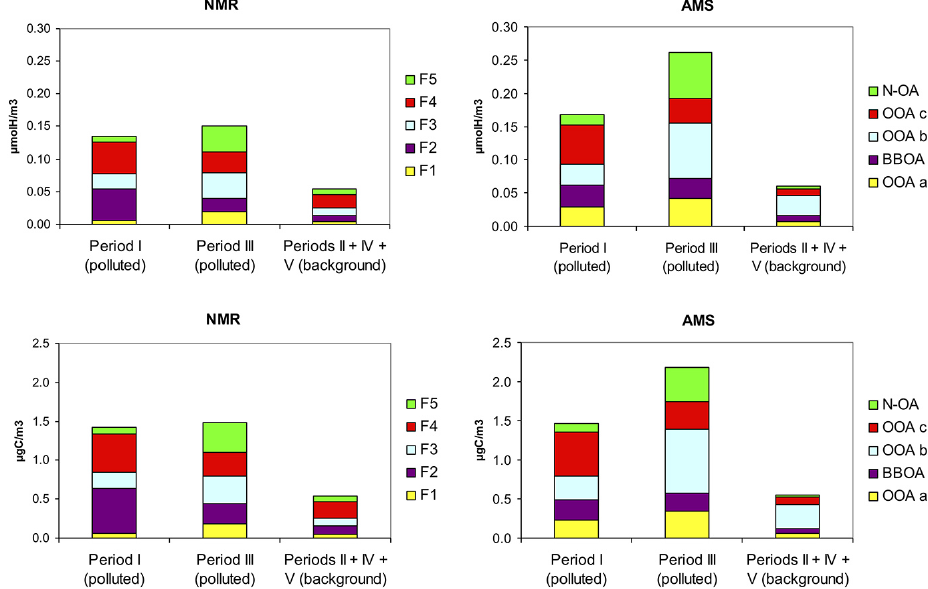
Figure 6. Average concentrations of NMR and AMS factors for WSOC and OOA, respectively, in the three main periods of the field campaign. Concentrations are expressed in hydrogen (upper panels) and carbon units (lower panels). Table 5. Correlation matrix between NMR and AMS factors. Only R values > 0.3 are